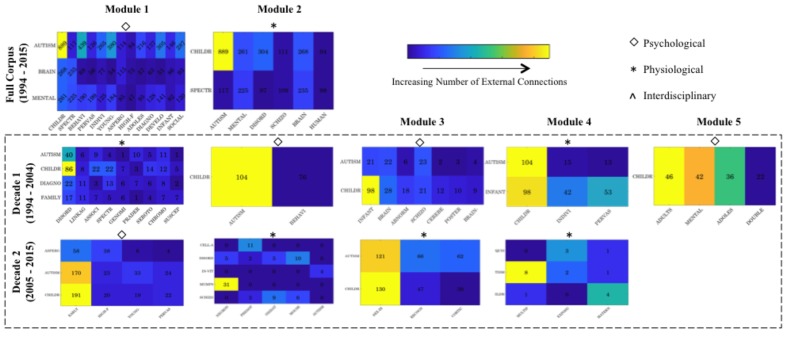
Summary matrices visualizing the external connections between modules identified across each level of the corpus. Prominent internal module keywords are indicated on the x-axis, while primary external module partner keywords are represented on the y-axis. Note external partner keyword (y-axis) can appear more than once across multiple external connections for individual modules. For instance, the term Brain acts as a prominent external connection for more than one module, and thus is a core network hub enabling multiple module connections. Matrix colors are indicative of normalized levels of external connectivity, with lighter colors denoting a larger number of normalized connections (original count data is also indicated). The top panel provides an overview of the Full Corpus modularity analytics demonstrating cross talk between the psychologically themed M1 and physiologically themed M2. The two lower panels illustrate Decade 1 and Decade 2 modularity analytics respectively, demonstrating external connections between core modules. While Decade 1’s self-identified modules appear to display nuanced levels of integration in M1 and M3, closer inspection demonstrates these are limited to arguably higher-level external descriptor terminology such as ‘Autism’ and ‘Children.’ Further, Decade 2 M2 and M4 display a range of external junctures, yet these appear to be largely intra-thematic. For yearly (1994, 2006, 2015) assessment see Supplementary Figure 4. For larger high resolution figures please see https://figshare.com/s/3edd5690135926764d04.